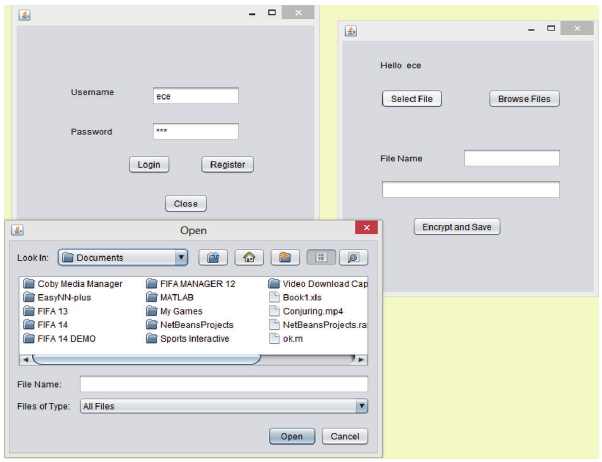
Figure 7: Selecting a file.